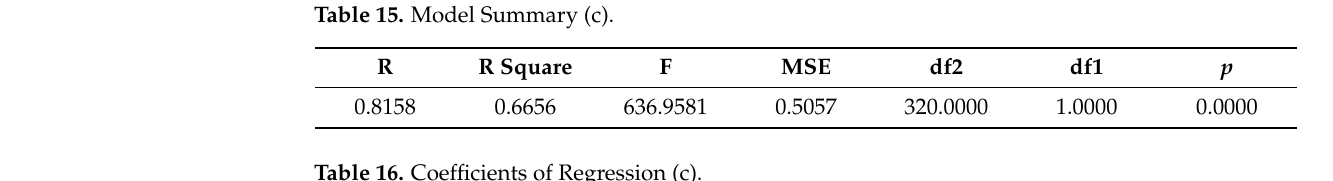
Table 16. Coefficients of Regression